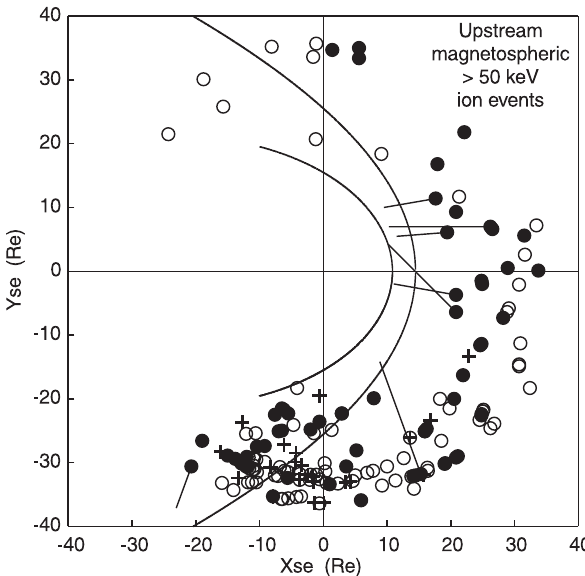
Fig. 1. Scatter plots of locations of upstream magnetospheric ion bursts. Bursts of low ( crosses ), moderate ( open circles ), and high ( solid circles ) intensities are indicated. The straight lines indicate the direction of the IMF and the connection point with the bow shock in the case of bursts with the highest intensities. The statistical results suggest that the magnetospheric ~ 50 keV ions escape preferentially from the dawn bow